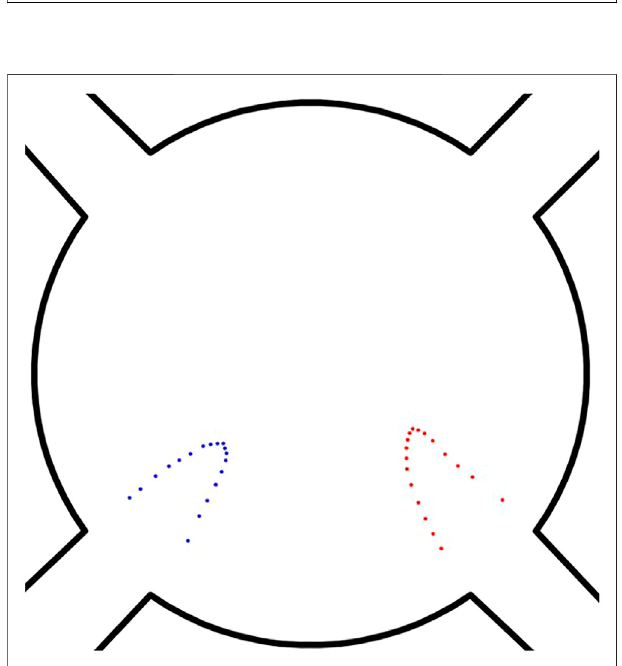
FIGURE. 9 | Scheme of the calculation procedure of dx i .